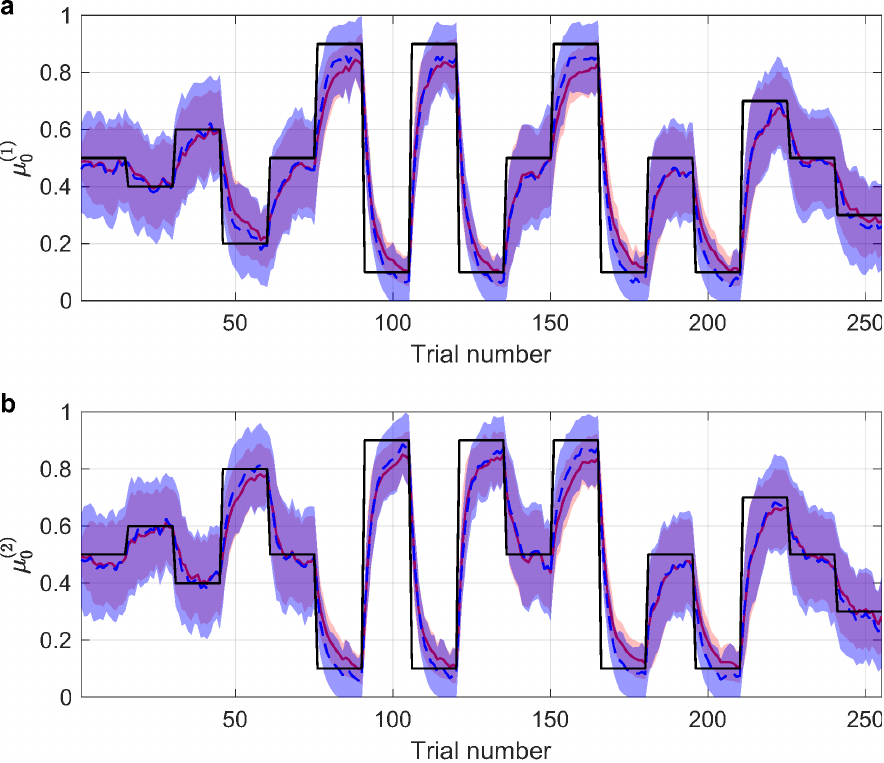
Figure 9. The mean inference trajectory ¯ T i ( i = 1,2 ) of the predicted states of the two-armed bandit x 0 . ( a ) The evolution of mean inference trajectories corresponding to µ evolution of mean inference trajectories corresponding to µ groundtruth is shown by black lines. The mean inference trajectories given by the Bayesian agent and the RW agent are in red and blue, respectively. The shaded areas correspond to the standard σ T deviations i ±